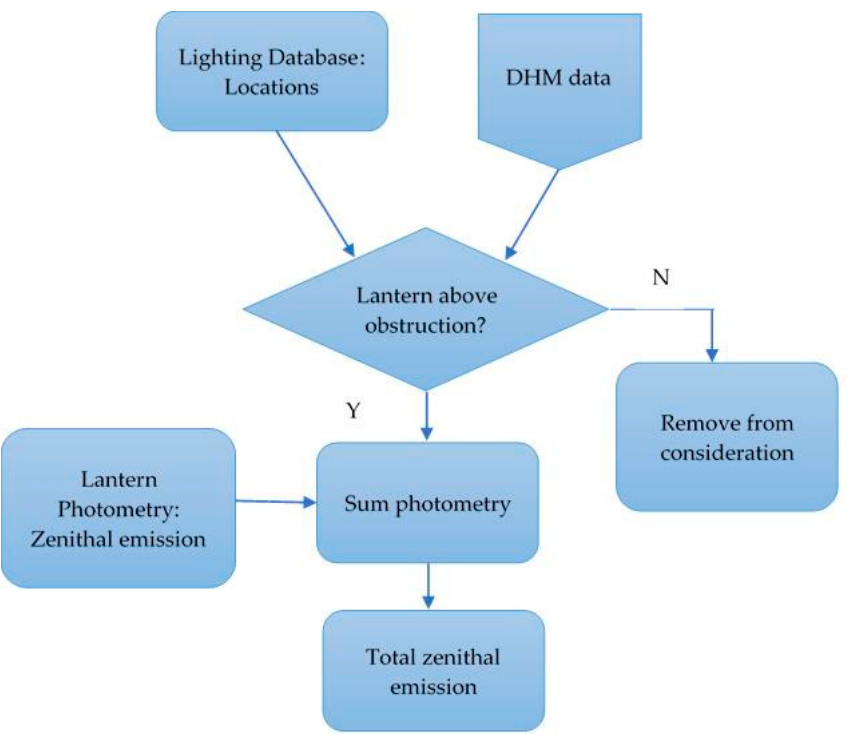
Figure A2. Flowchart of decision to include lantern in direct zenithal emission.